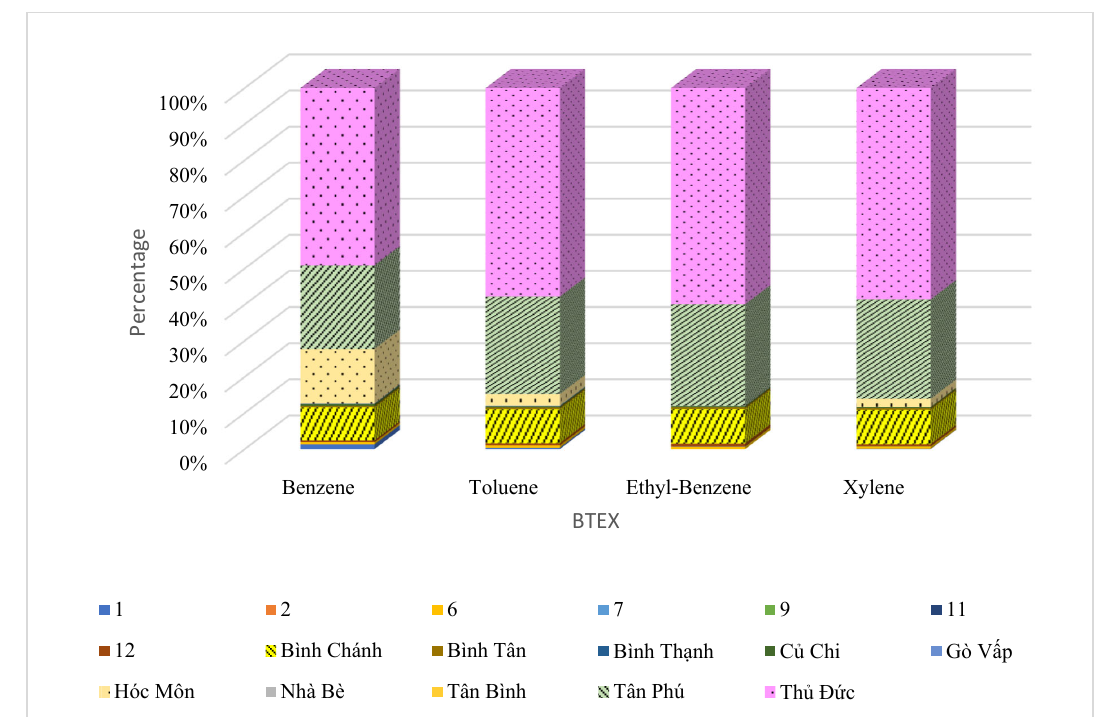
Figure 2. Contribution of BTEX emission source from districts in Ho Chi Minh City .